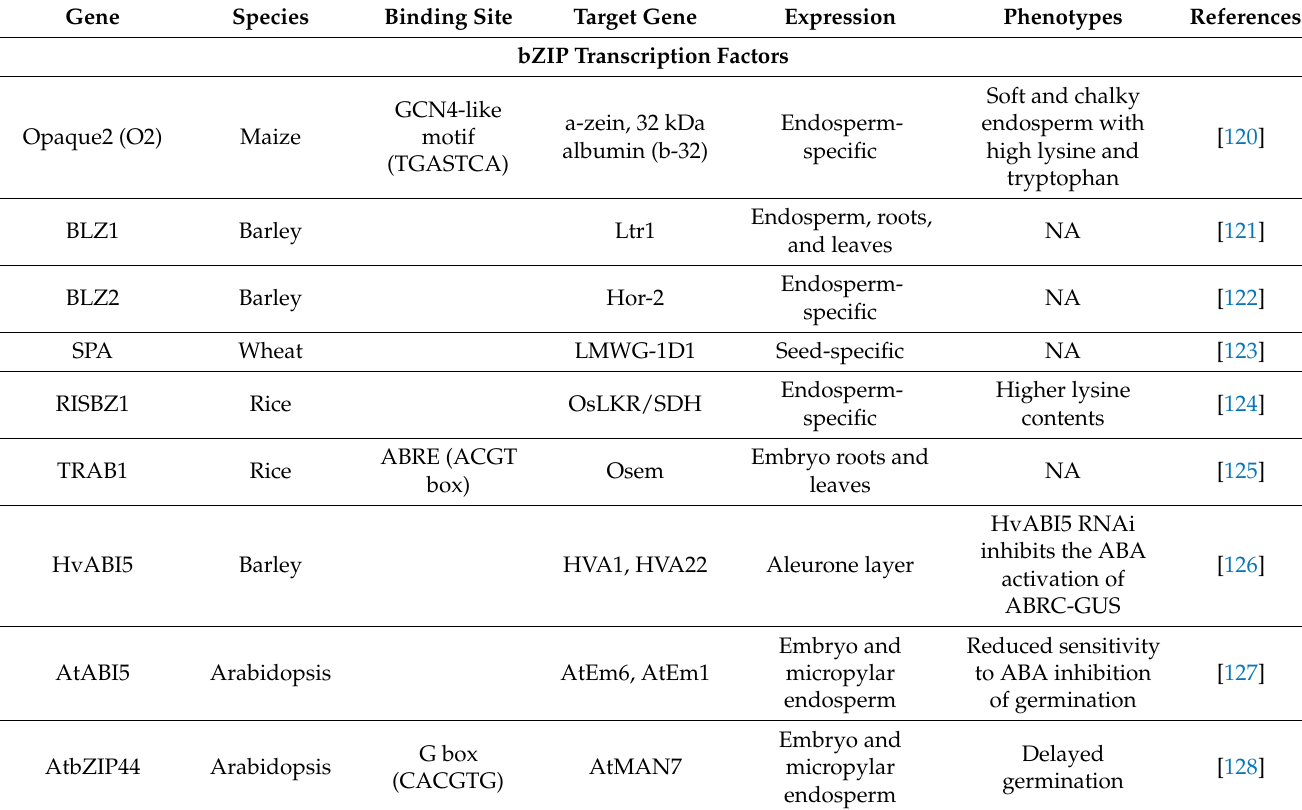
Figure 3. Illustration of the embryo and endosperm in the seeds of tomato ( a ), Arabidopsis ( b ), pea ( c ), and wheat ( d ). Endosperm (END), embryo (EMB), micropylar endosperm (ME), radicle (RAD), seed coat (SC), cotyledons (COT), embryonic axis (AXS), starchy endosperm (STE), aleurone layer (AL). Table 3. Transcription factors expressed in endosperms involved in the germination of seeds.